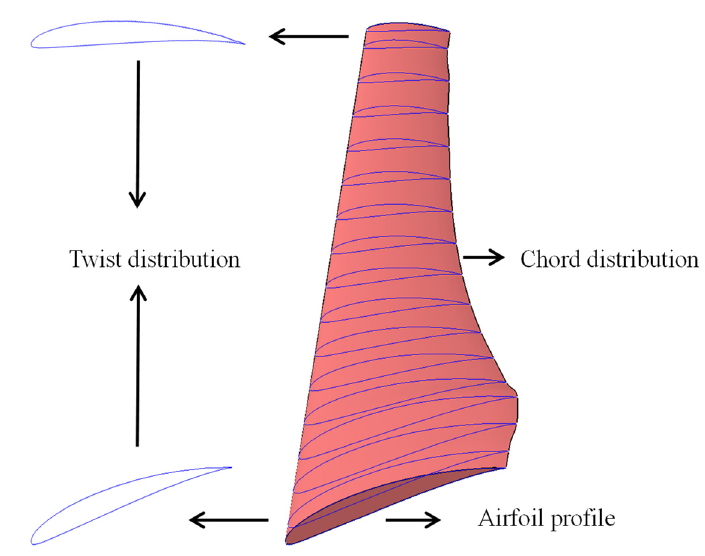
Figure 1. Influential parameters in the shape of a wind turbine blade.